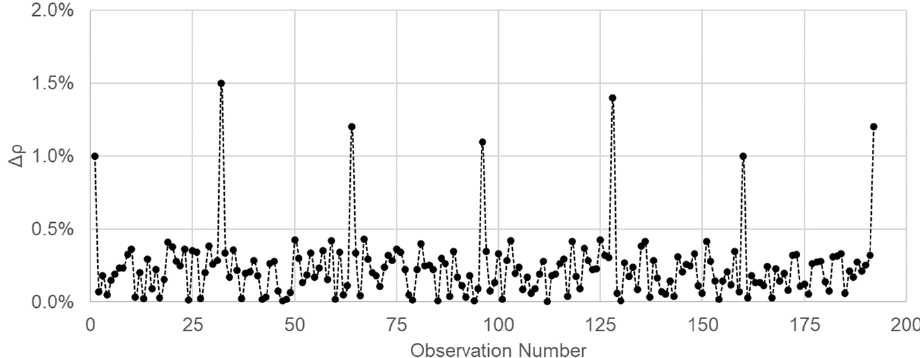
Figure 5. Difference between prediction (inversion) and the observation in log10 scale. Note that the peak value refers to the locations of current injections.